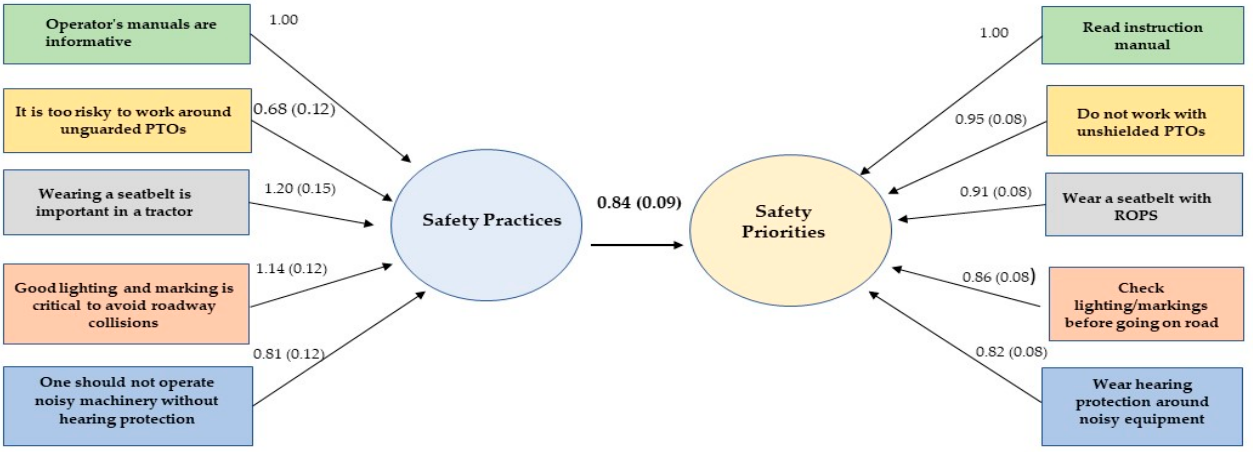
Figure 2. Structural equation model of machinery safety practices predicting safety priorities in 326 farm and ranch operators in 7 Midwest states, 2021.